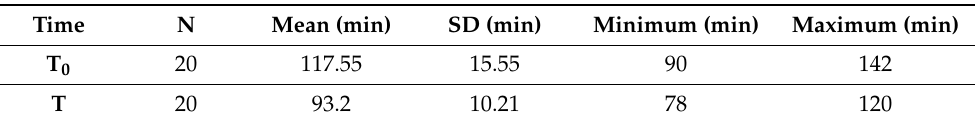
Table 7. Descriptive statistics regarding the operative time without rehearsals ( T 0 ) and with per- formed simulations/rehearsals on 3D-printed models ( T ).